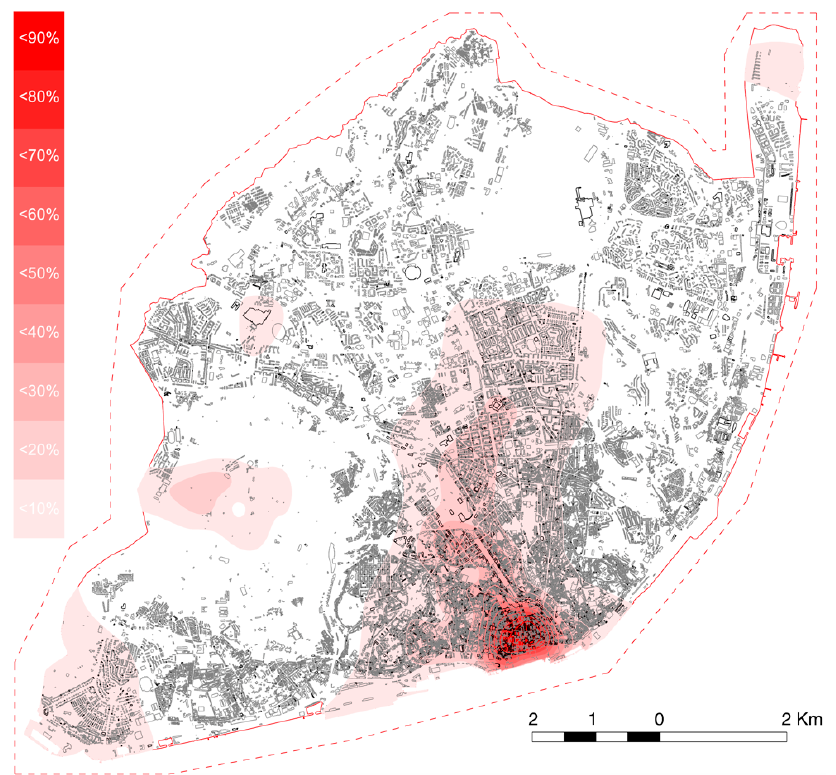
Figure 6. Dual KDE of issued permits for building renovation in the 2010–2016 period in the city of Lisbon. Output of Grasshopper to Rhino. Source: